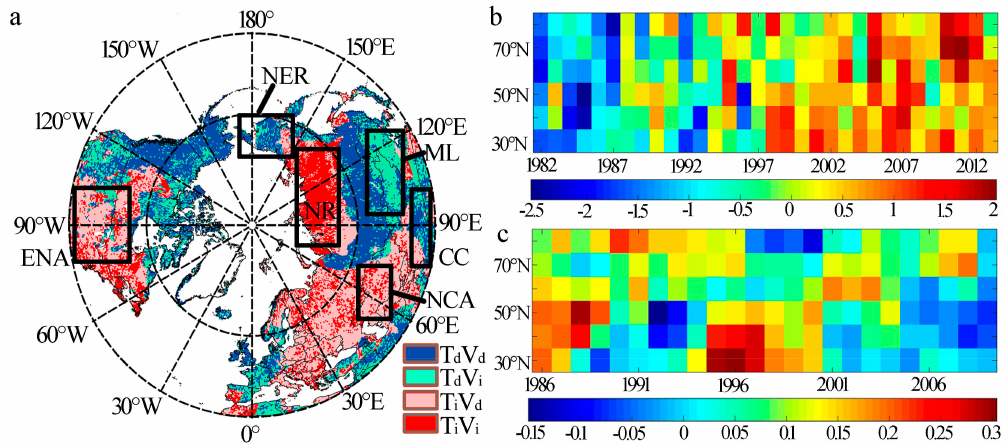
Figure 1. Distribution of warming hiatuses. NER: northeastern Russia; ML: Mongolia; CC: central China; ENA: eastern North America; NR: northern Russia; NCA: northern central Asia. ( a ) Variations in temperature and Normalized Difference Vegetation Index (NDVI) before and after the turning year when the temperature trend started changing. T d V d represents the decrease in the NDVI caused by a warming hiatus. T d V i refers to the increase in the NDVI caused by a warming hiatus, while T i V d and T i V i represent the decrease and increase in the NDVI caused by accelerated warming; ( b ) The temperature anomaly from 1982–2013; ( c ) Variation trend of the temperature anomalies in each latitudinal zone. The x -axes of ( b , c ) represent the year, and the y -axes represent the